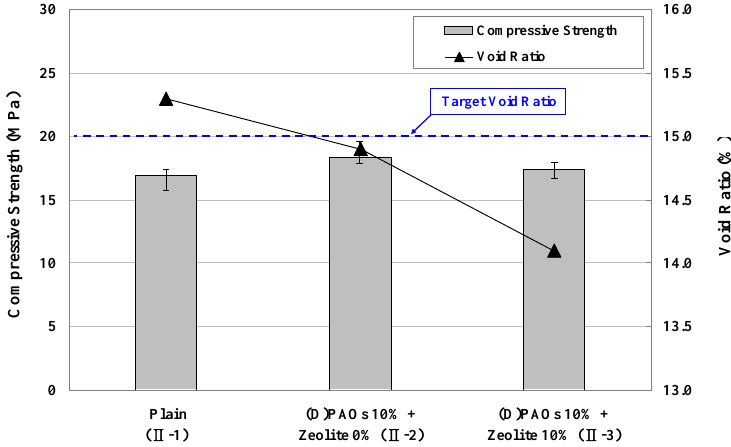
Figure 7. Compressive strength of porous concretes produced with (D)PAOs and zeolite.